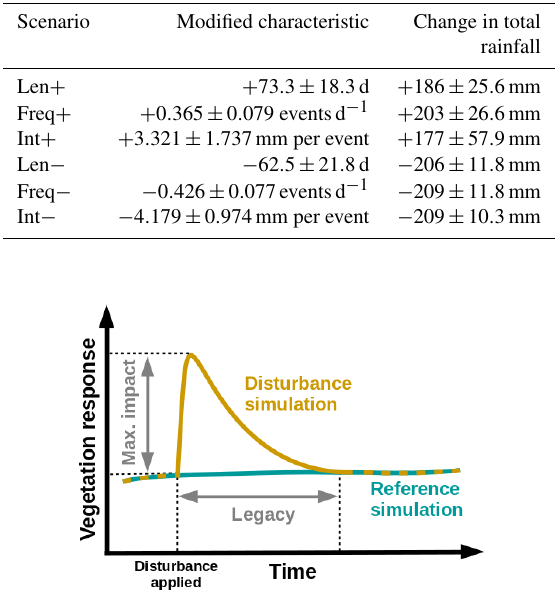
Figure 4. Concept of the model experimental set-up, consisting of a disturbance simulation in which a rainfall disturbance is applied, and a reference run, which is based on the same meteorological drivers but without any disturbance applied. Vegetation impact is described by maximum impact (amplitude) and legacy (years). The average impact is derived by subtracting the output of the reference simulations from the output of the disturbance simulations for each ensemble member and then taking the average of the result over all ensemble members. The legacy is calculated as the last year for which the average impact is larger than its standard deviation.